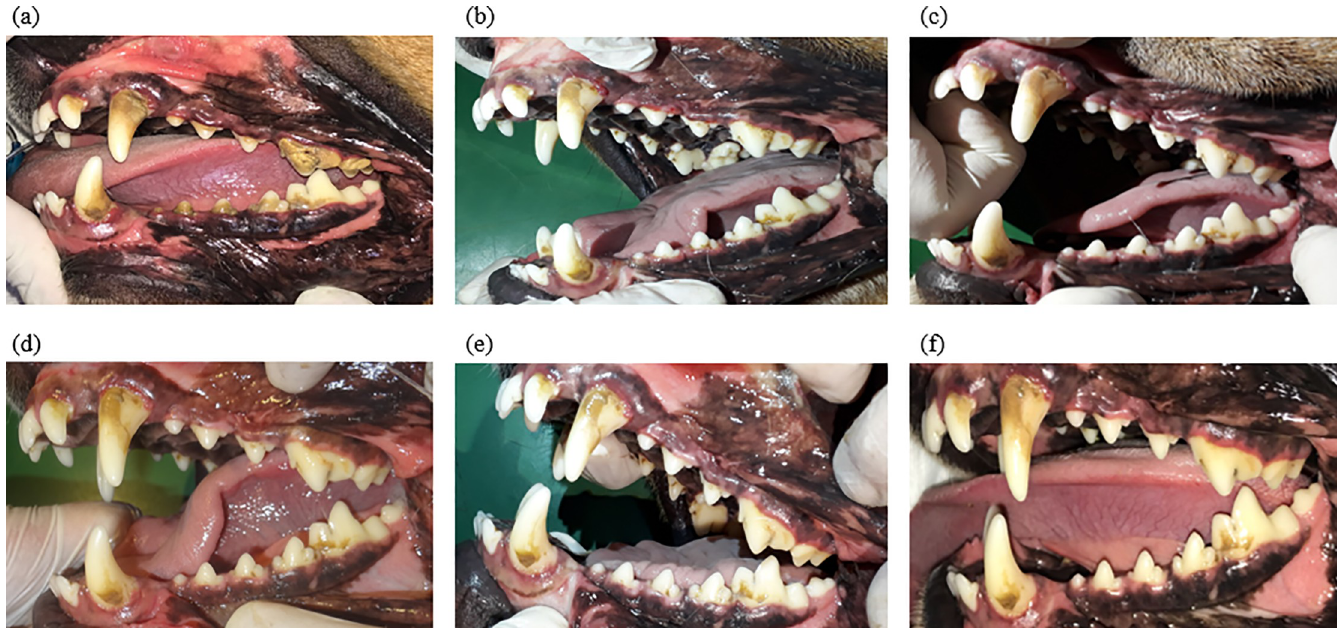
Fig 2. Left dental arcade of the same dog at days 0, 3, 6, 9, 12, and 14 (a–f, respectively) after daily supplementation of autoclaved compact bone.